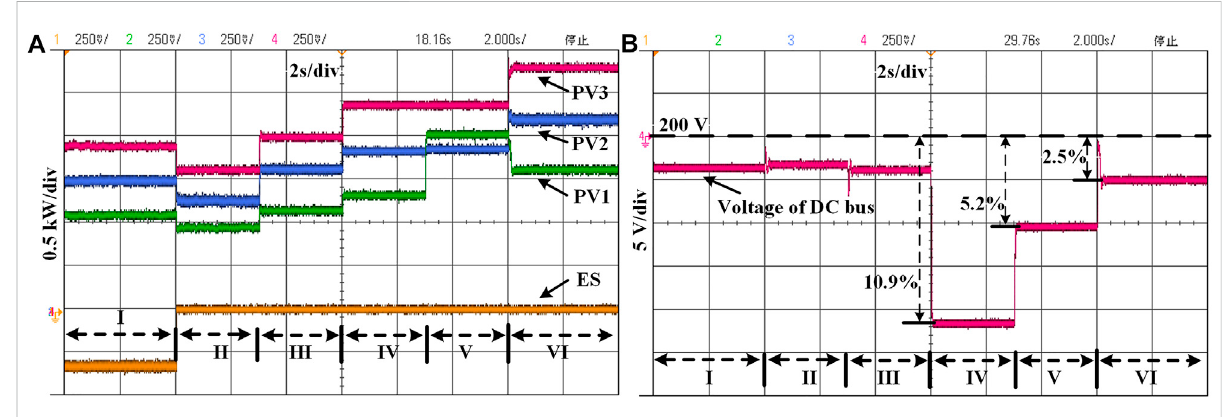
FIGURE 9 System responses under step-changed load and solar irradiation (A) Power outputs of PV1, PV2, PV3, and ES. (B) DC-bus voltage.